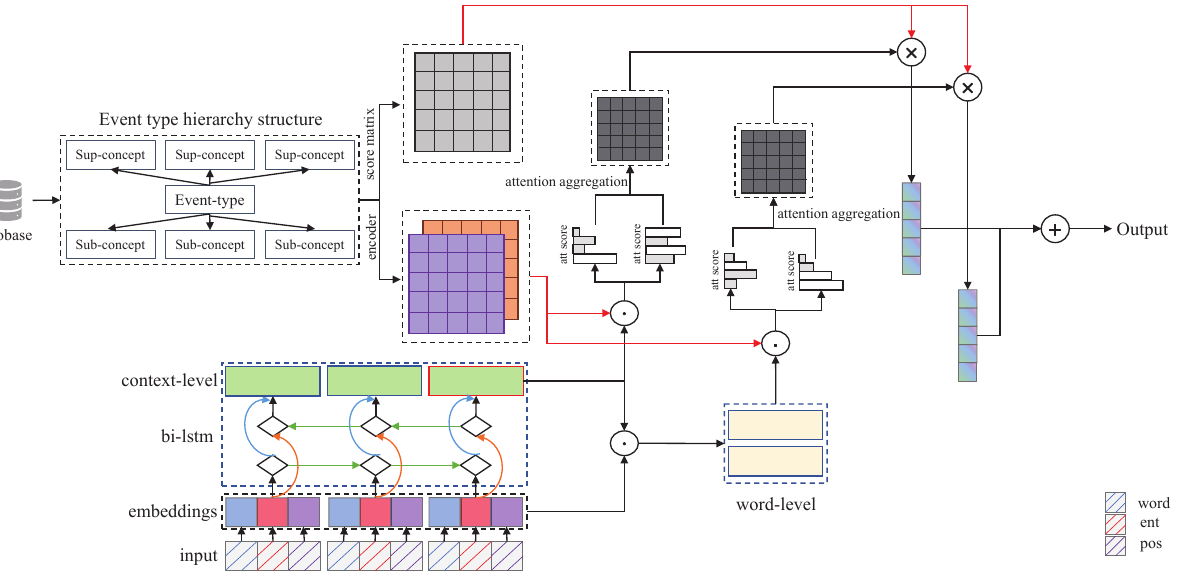
Figure 3. The architecture overview of THEED. It consists of three components. Component 1: Instance encoding. Component 2: Type hierarchy concept module. Component 3: Binary encoding. (The type hierarchy concept module only indicates one example. Due to space constraints, confidence is not marked on the